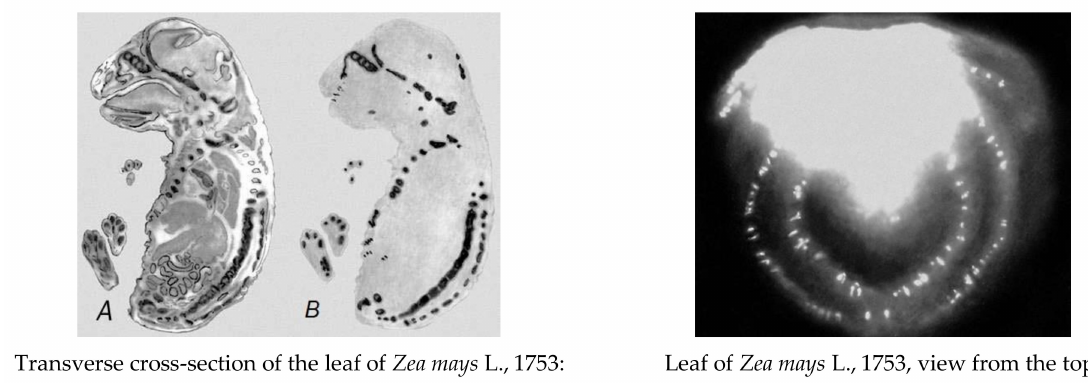
Figure 4. Distribution of the labelled rimsulfuron over the leaf of Zea mays L., 1753